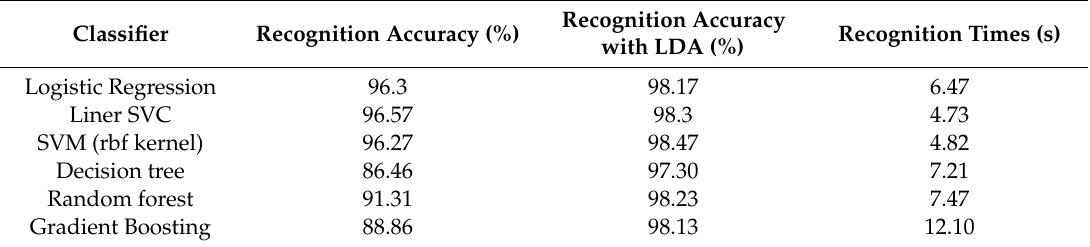
Table 4. Recognition accuracy in machine